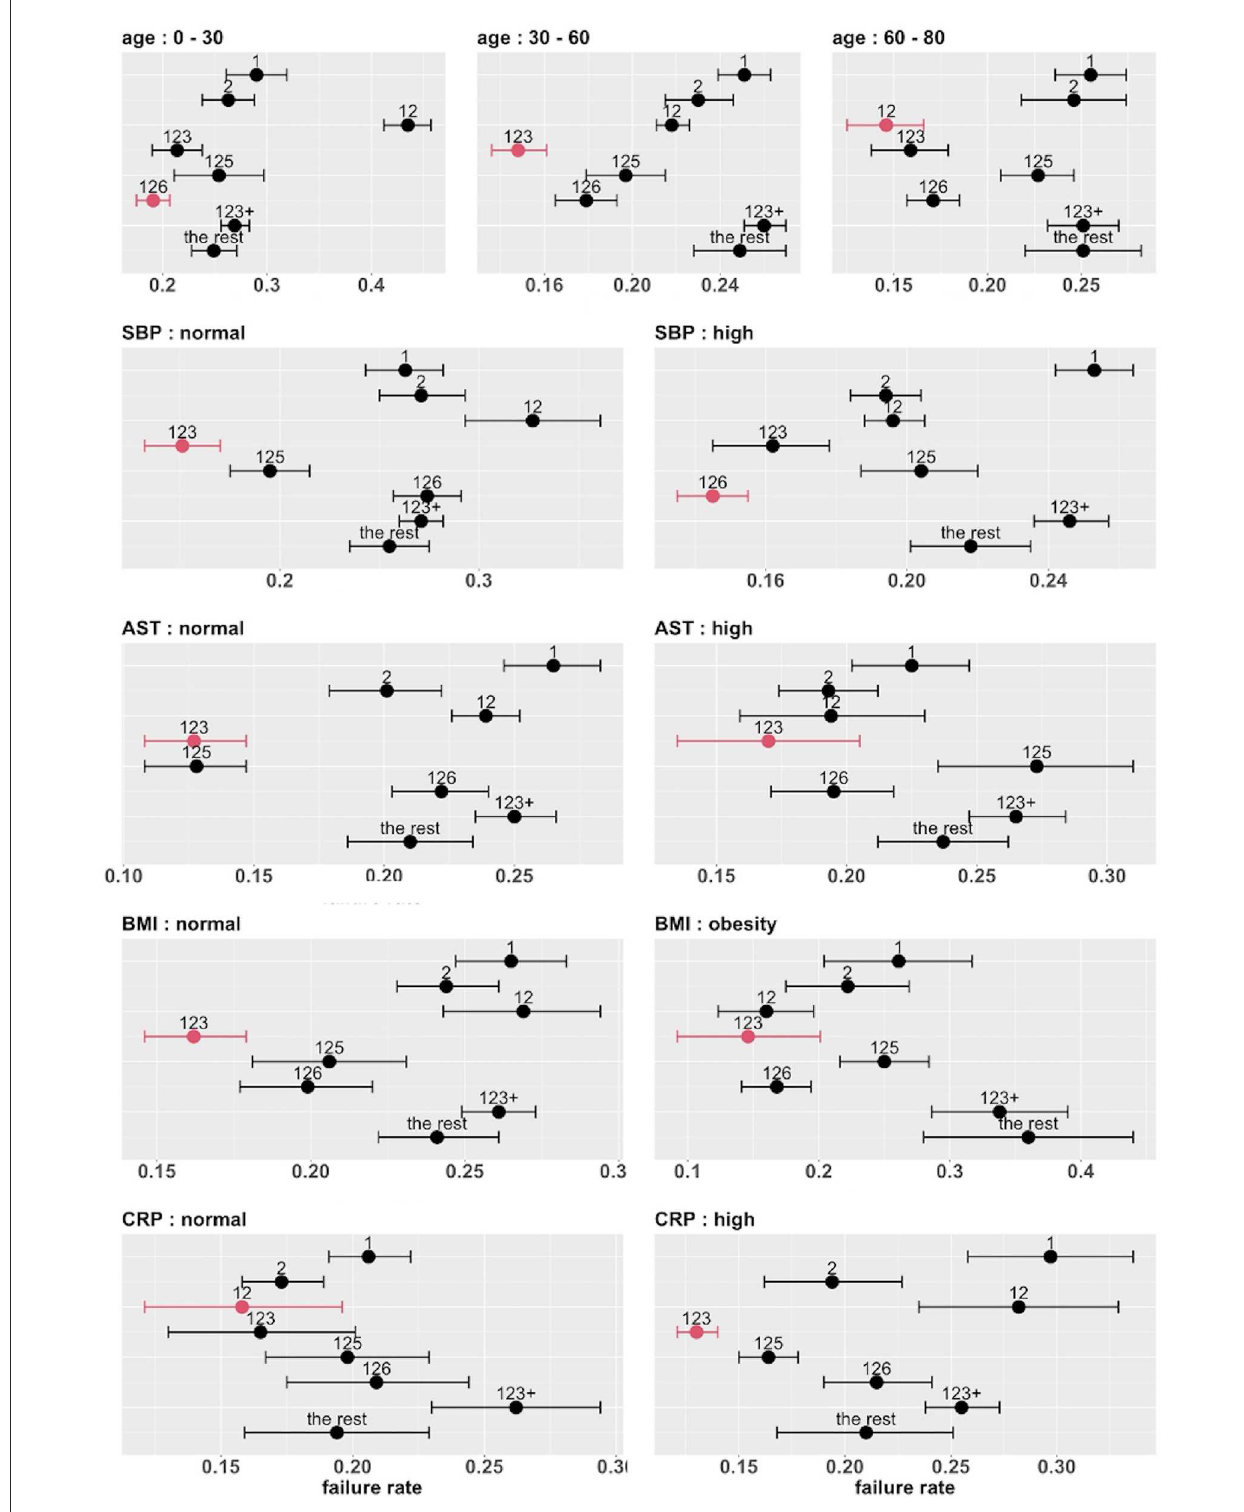
FIGURE6 Estimated failure rates and 95% confidence intervals for the eight combinatorial drug treatments under consideration (with no adjustment for multiplicity), in subgroups defined by the top five covariates (one at a time). The lowest estimated failure rate in each subgroup is shown in red.